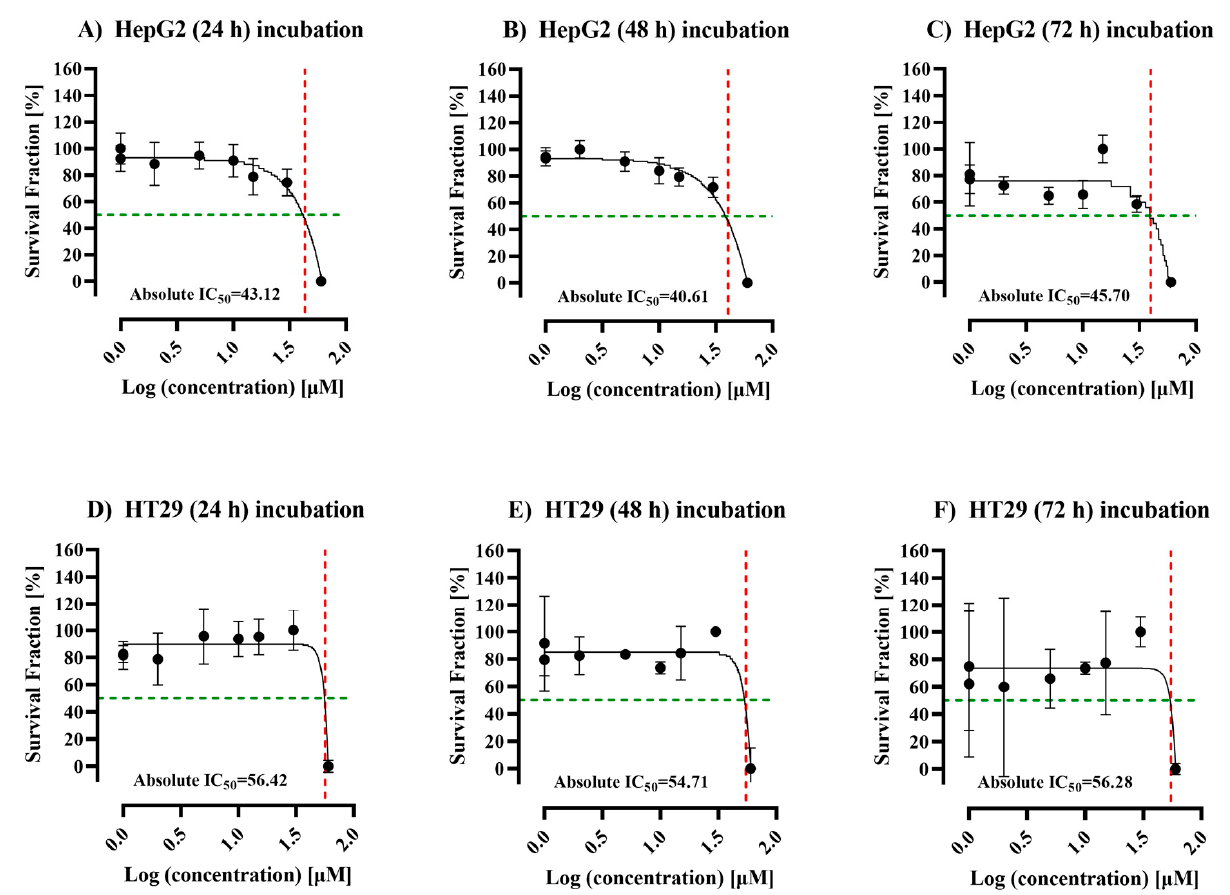
Figure 1. Dose–response curve in HepG2, and HT29 cells after treatment with acetyl-L-carnitine (ALC) at 24, 48, and 72 h. ( A – C ) HepG2 cell line, ( D – F ) HT29 cell line. Both cell lines were treated with 0, 0.5, 5, 10, 15, 30, and 60 µ M/mL at 24, 48, 72 h. The viability was measured at different time points for each cell line. The point where the red dashed line meets the green dashed line is the absolute IC 50 . The concentration was transformed to log concentration and normalized to percentage, then the mean of six repeats was plotted by nonlinear regression. The error bars correspond to standard deviation (SD).